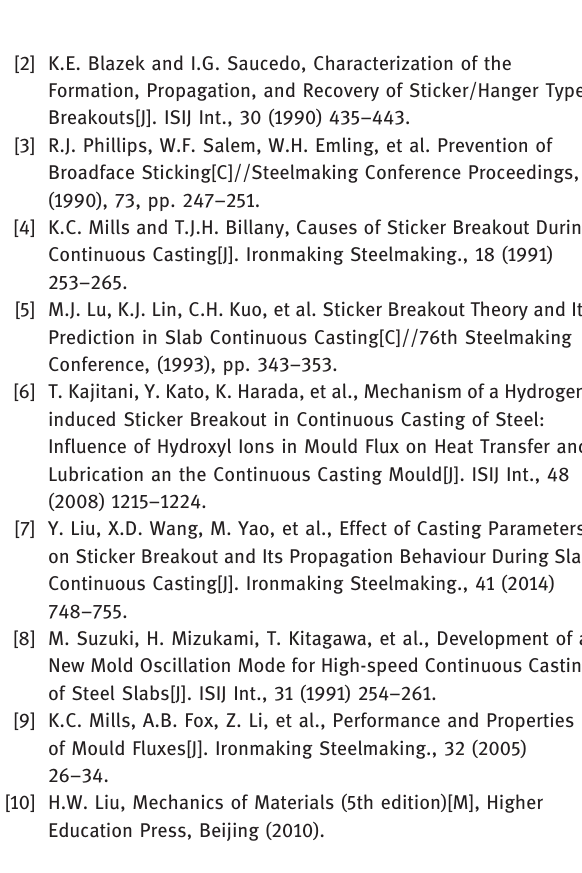
Figure 5: Heat flux variation of each face of the mold before breakout for sample